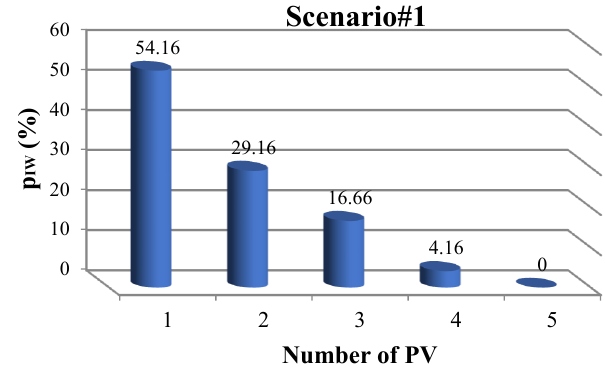
Figure 7. Change compared to PV number in Scenario 1. Figure 8. Change compared to PV number in Scenario 1.